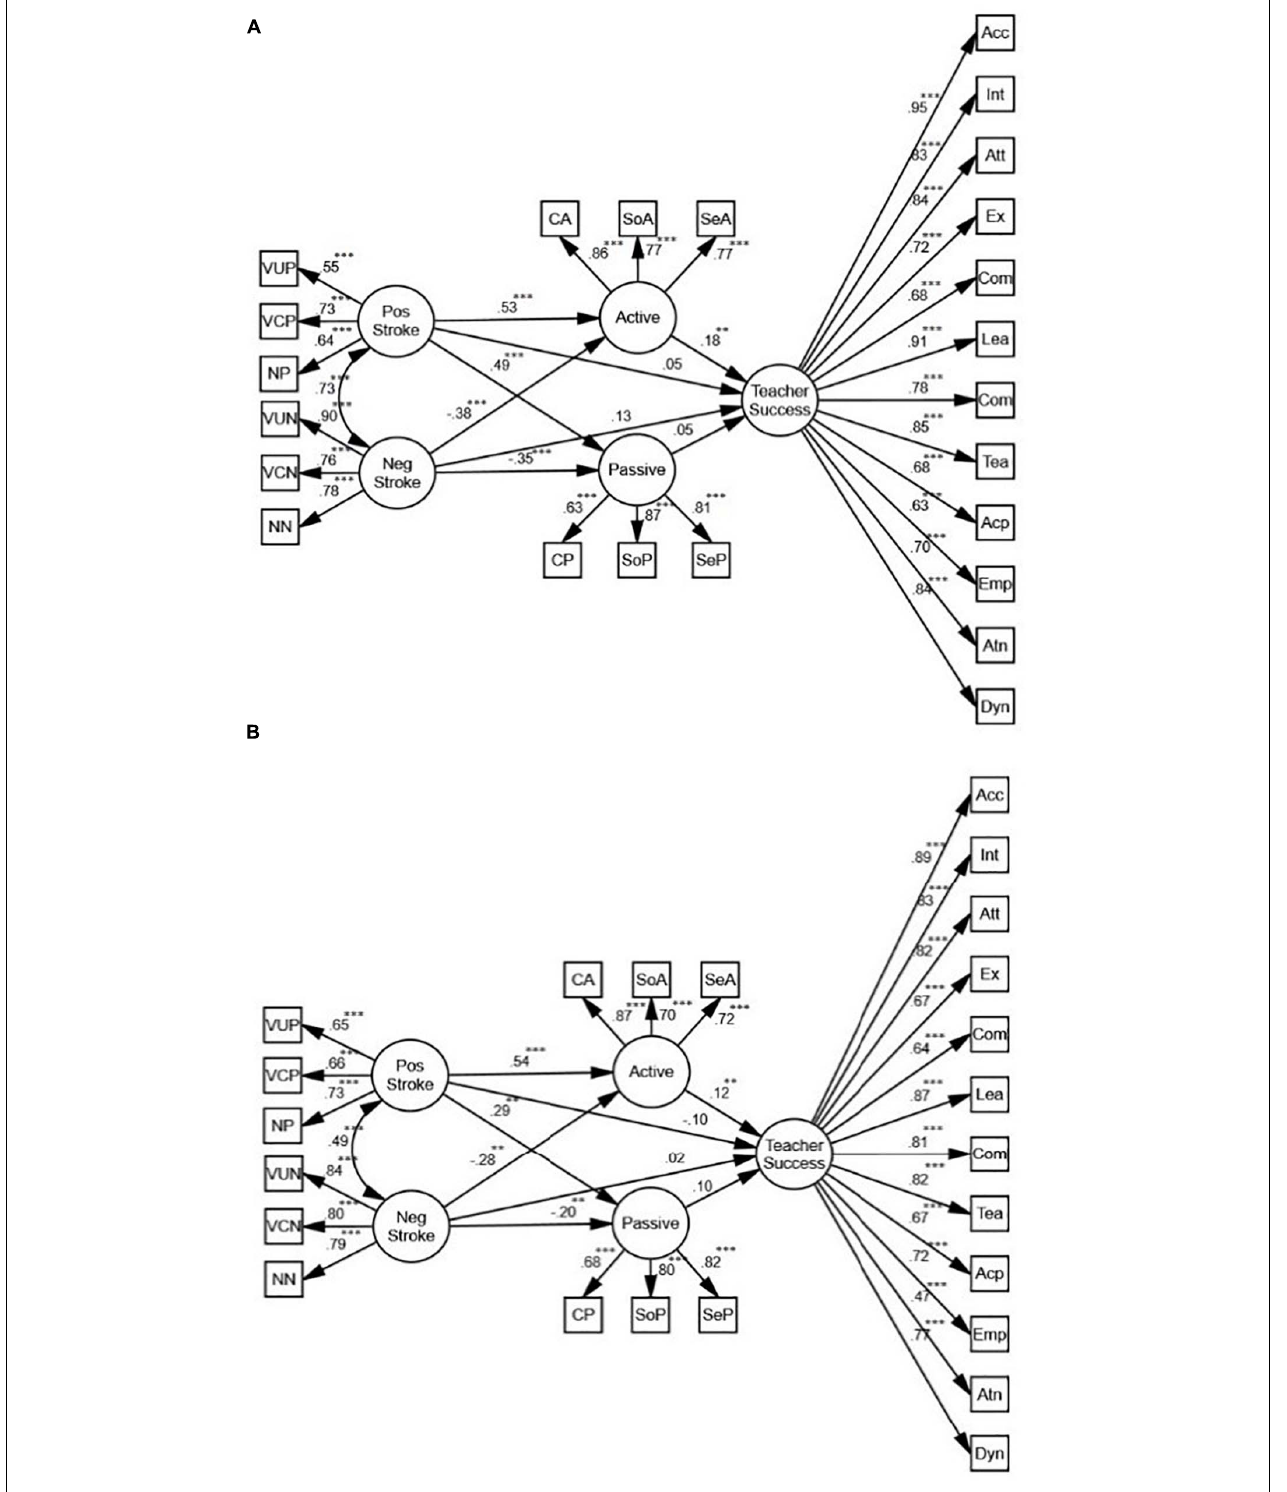
FIGURE 5 | (A) The schematic representation of the relationships between positive (pos) and negative (neg) stroke, active and passive motivation, and teacher success (Females). (B) The schematic representation of the relationships between positive and negative stroke, active and passive motivation, and teacher success (Males) (** p < 0.01, *** p <